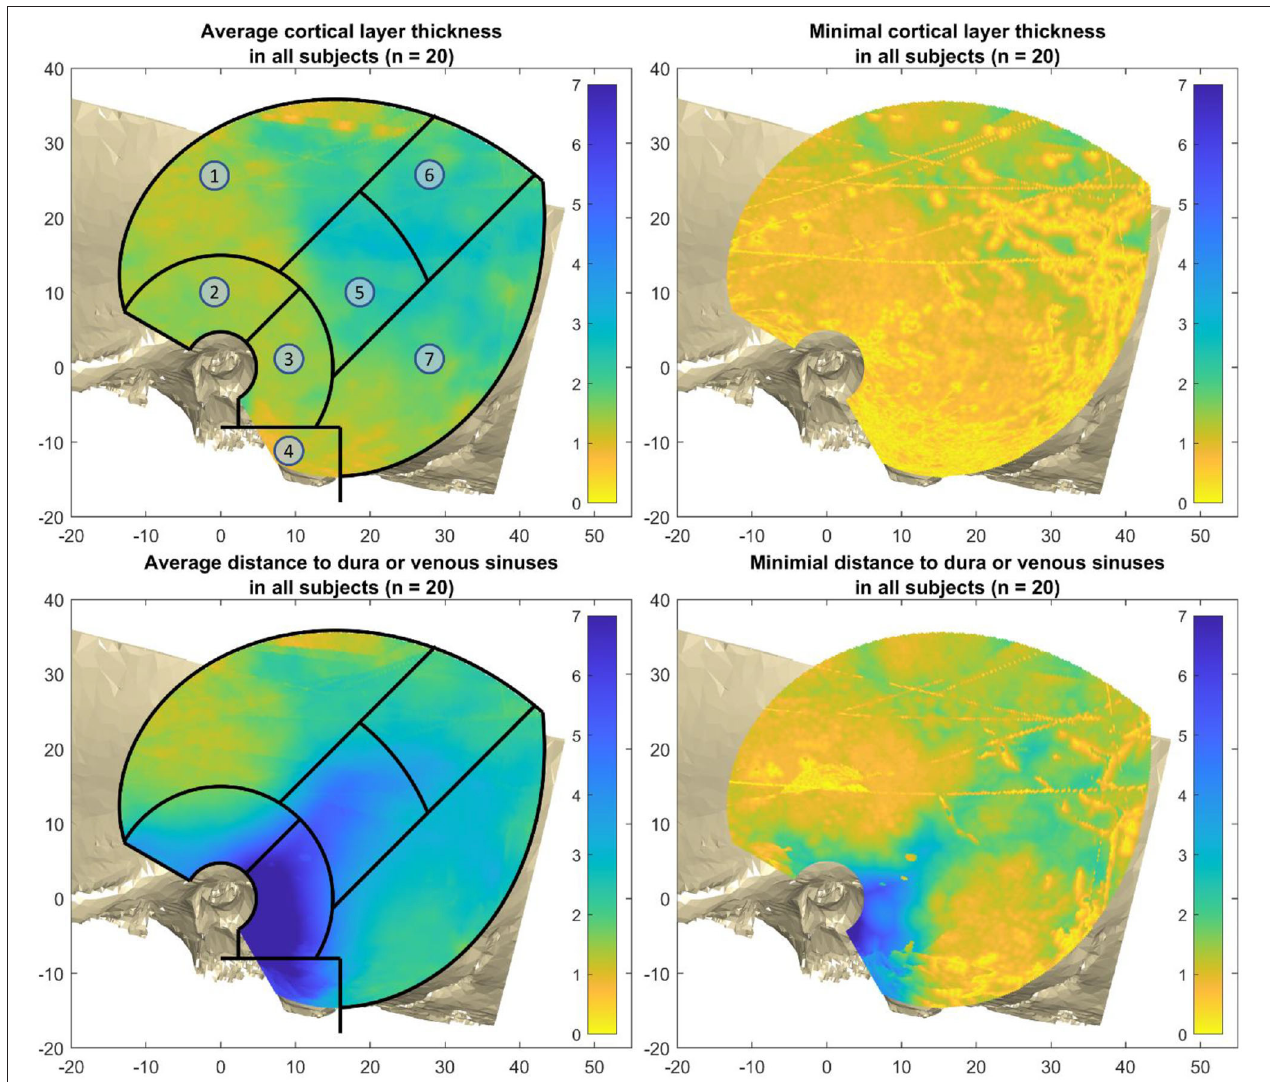
FIGURE 6 | Average and minimal thicknesses over all 20 subjects. Top left: the average cortical layer thickness (CLT). Top right: the minimal cortical layer thickness over all subjects. Bottom right: The average distance to dura or venous sinuses (DDVS). Bottom right: the minimal distance to dura or venous sinuses over all subjects. The regions are as follows: 1) superior temporal surface, 2) approximately the middle fossa, 3) mastoid region, 4) mastoid tip, 5) petrous pyramid, 6) parietal region, and 7) retrosigmoid